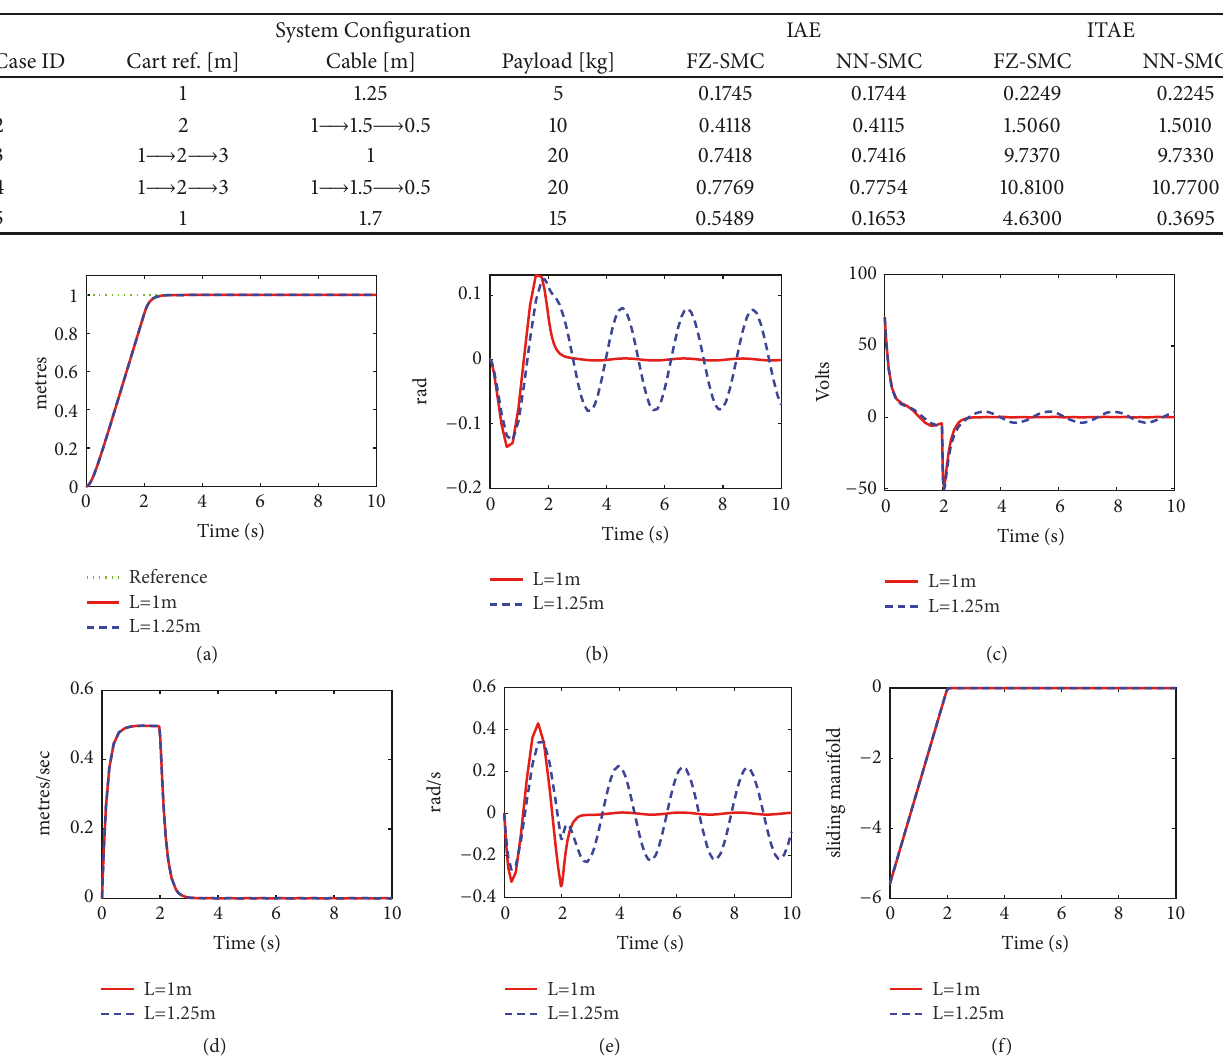
Table 4: Fuzzy-SMC and neural network-SMC comparisons based on IAE and ITAE.